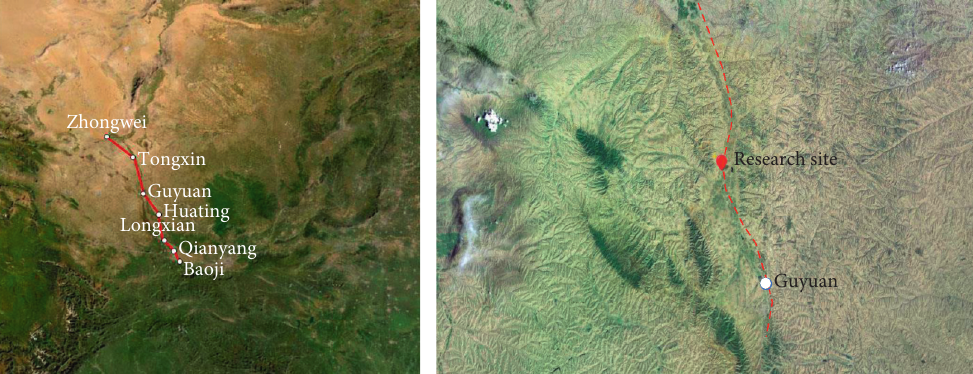
Figure 1: The location of research